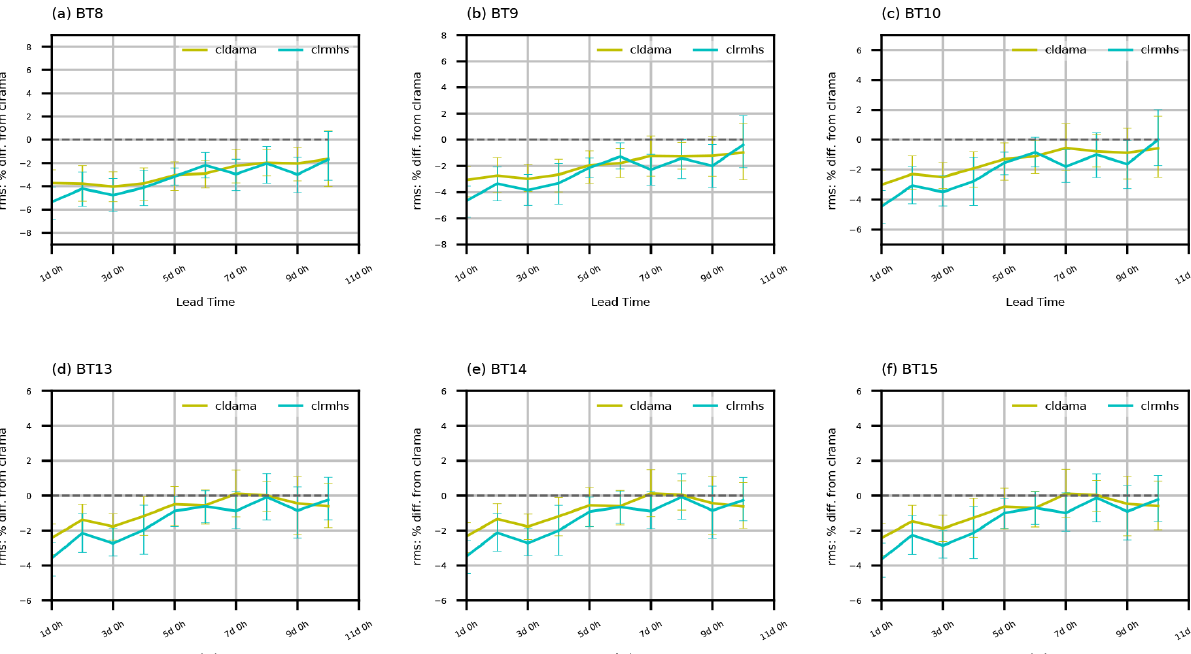
Figure 11. Similar to Fig. 8 but for RMSE in AHI’s six channels’ brightness temperature space.